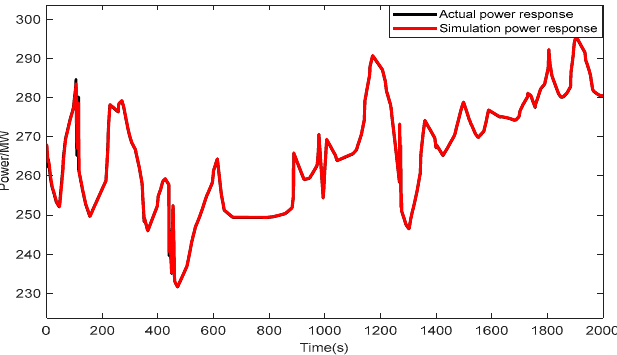
Figure 9. The actual and the simulation values of the unit power.